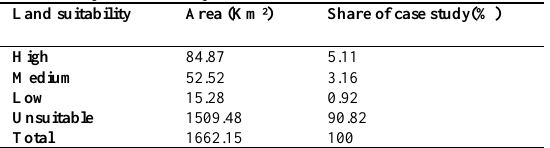
Table 7. The area and approximate share of each level of land